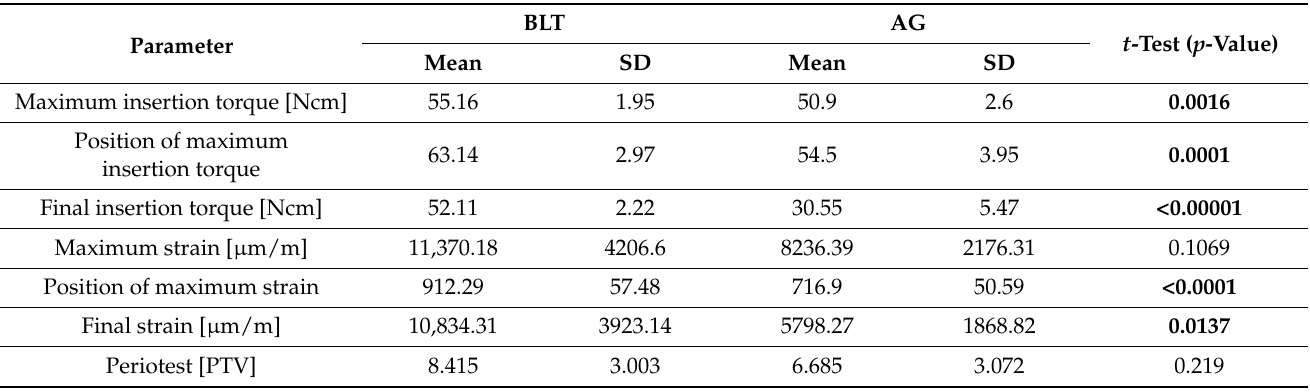
Figure 4. Strain development over time during implant insertion for both groups investigated with continuously increasing strain levels for Straumann BLT. Lower maximum strain was seen in AlfaGate implants coinciding with the bulky central part of the implant passing the cortical plate. Table 2. Mean values and standard deviations recorded for all parameters for both implant types. Results of t -tests for comparisons between the two implant groups are given as p -values with significant differences ( p < 0.05) written in